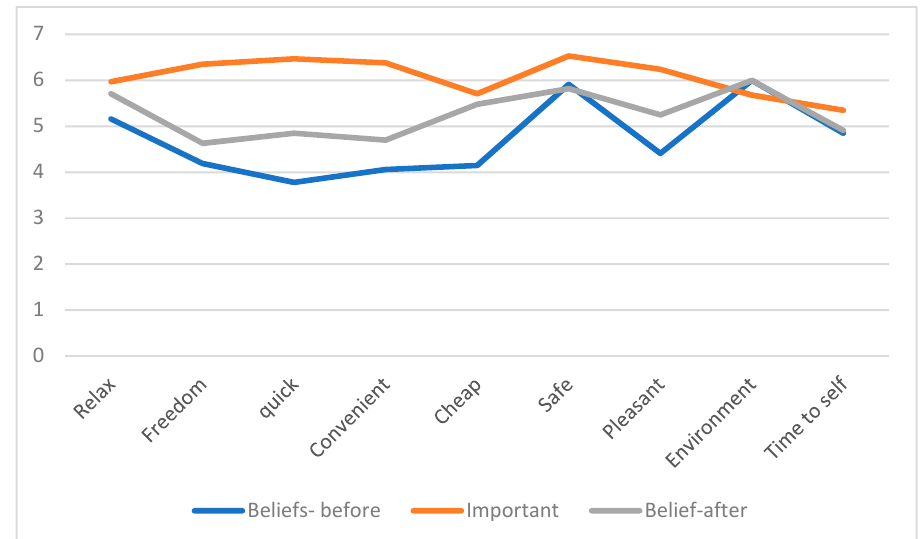
Figure 3. Importance and behavioural beliefs before and after the trial.